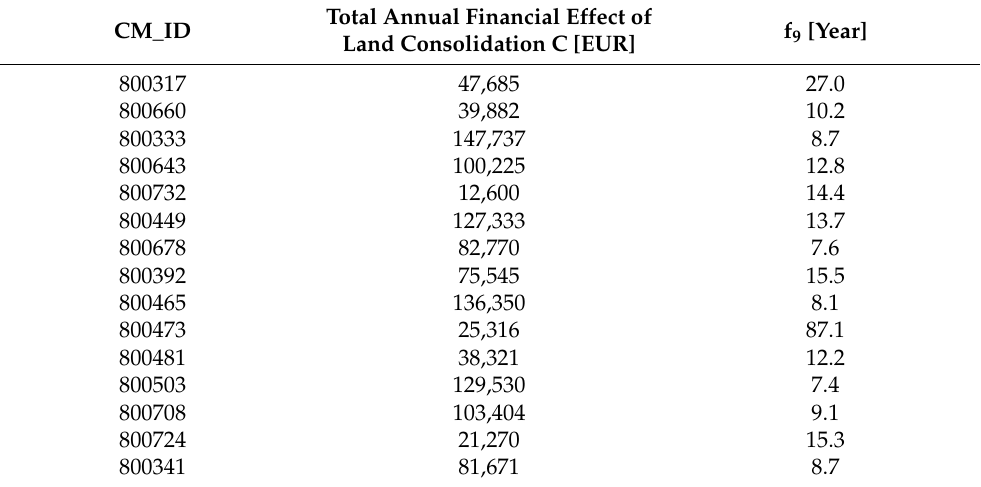
Table 5. Review of the total annual financial effect and return periods of assets invested into land consolidation (f 9 ).